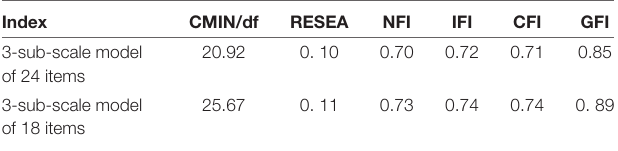
TABLE 2 | Items loadings, eigenvalues and variance of the SRS with PCA.